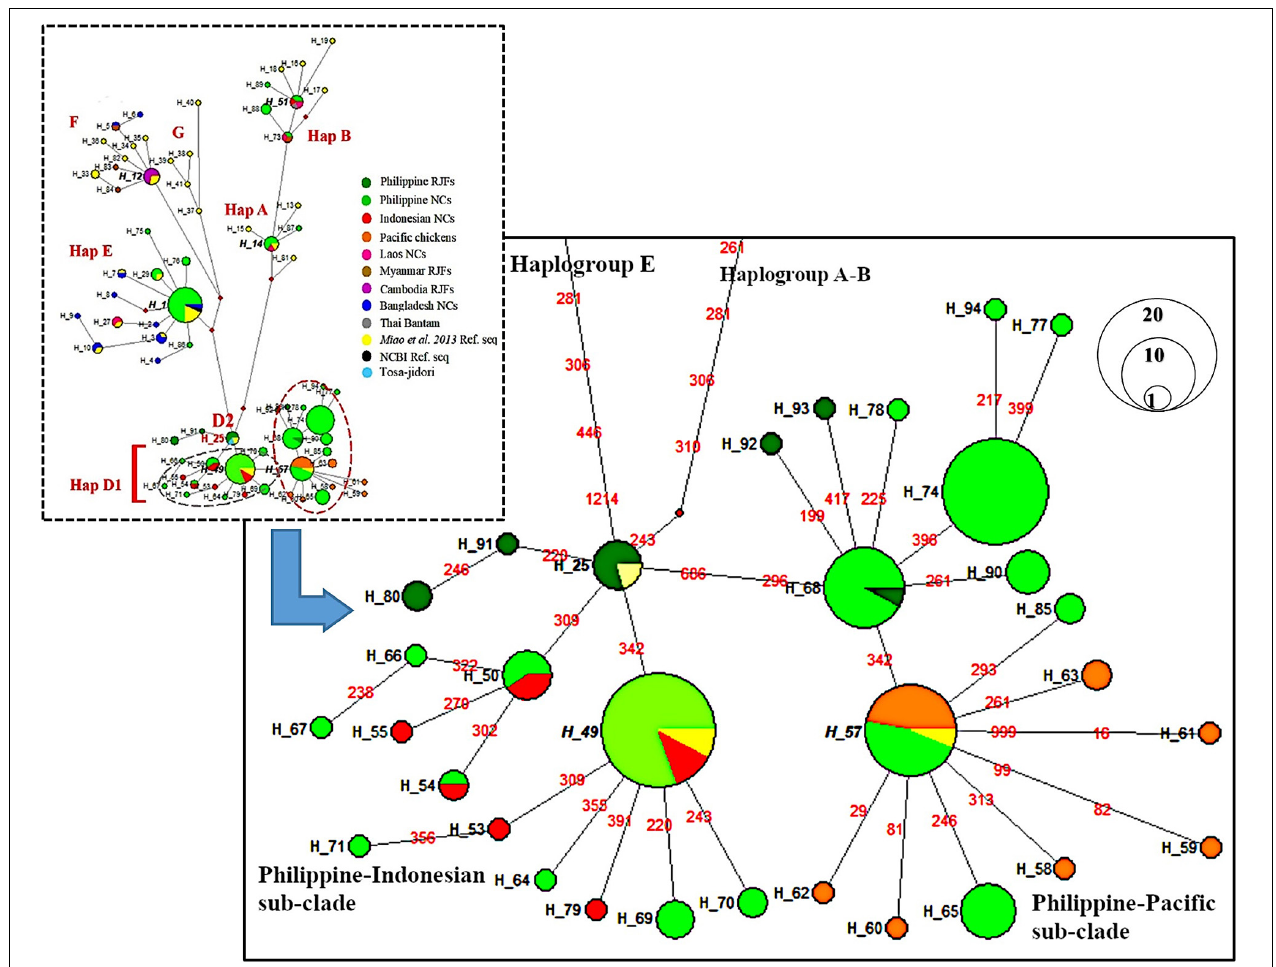
FIGURE 2 | Median-joining network of the complete mtDNA D-loop region (1,232 bp) depicting relationship of Philippine chickens, Indonesian chickens, and Pacific chickens. The area of each circle is proportional to the frequency of the corresponding haplotypes. The length of branch connecting to other haplotypes correspond to mutational